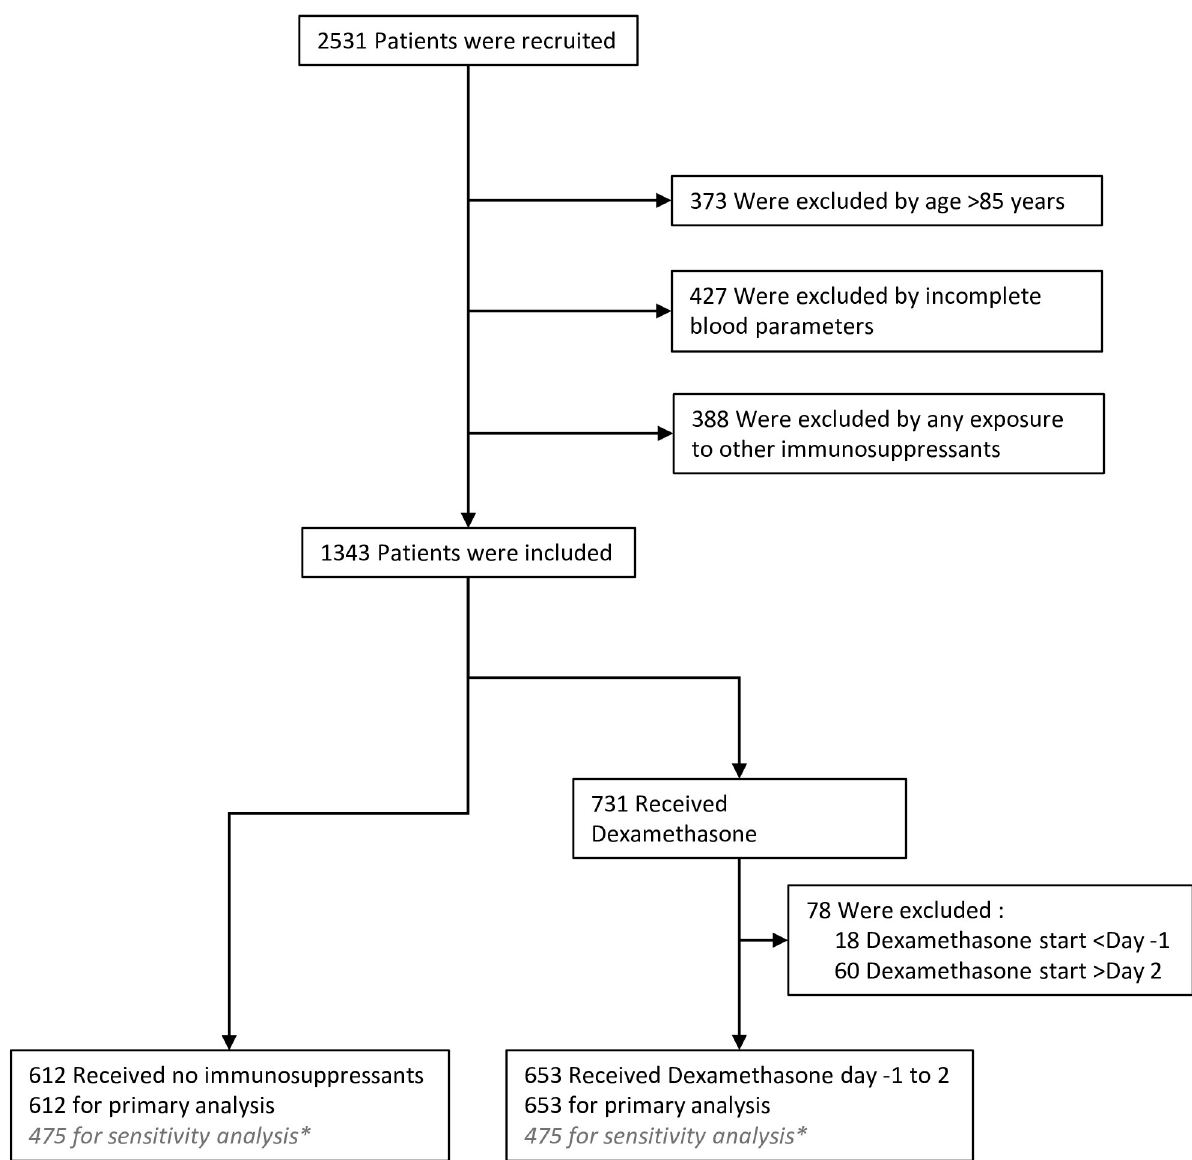
Fig 1. Enrolment, and inclusion in the primary analysis. Electronic records were available for 2531 of 2531 patients (100%) of hospitalised COVID- 19 cases. 373 cases were excluded due to age ( > 85 years), and 427 through incomplete blood parameter measurements. 388 cases received other immunosuppressants as well as or instead of dexamethasone and were excluded. 78 dexamethasone treated cases were excluded because the treatment was started before or after the window of